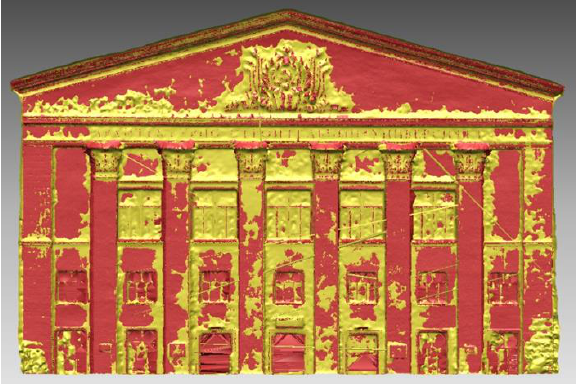
Figure 6. Fusing three-dimensional vector façade models